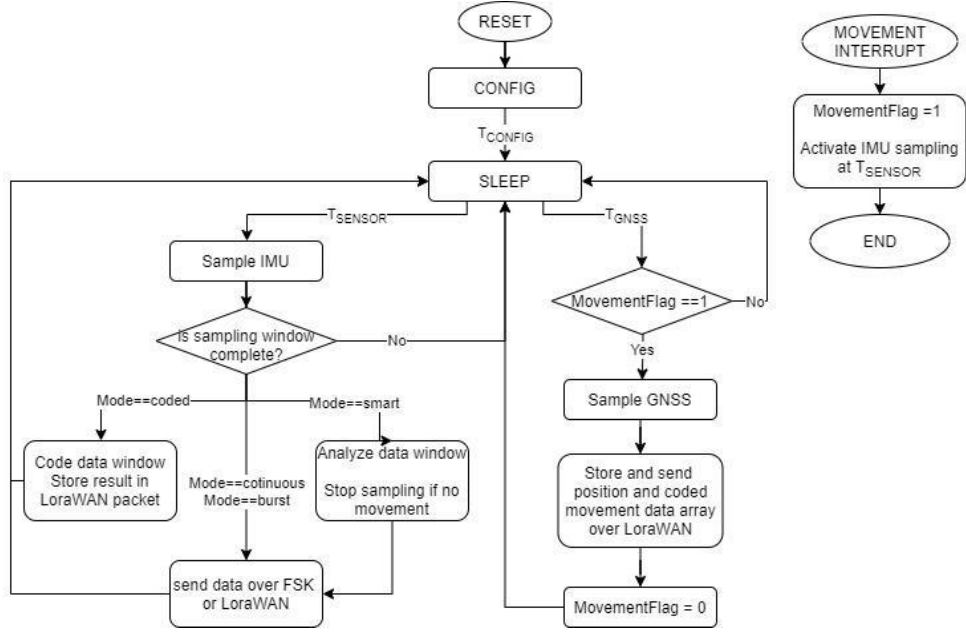
Figure 5. Firmware’s flow diagram.